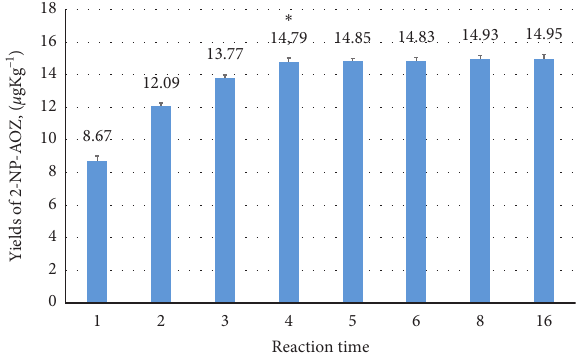
Figure 3: Detected 2-NP-AOZ from the incurred sample over the time under the chosen experimental condition with 14mL of 0.5M HCl at 45 ° C (mean ±